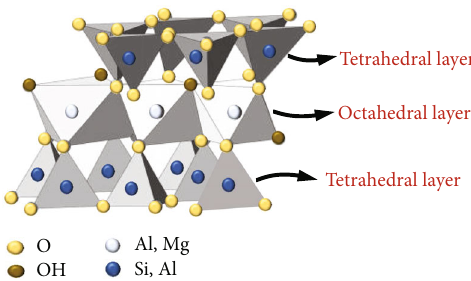
Figure 1: Structure of Mt. Modi fi ed from Reinholdt et al. [110].